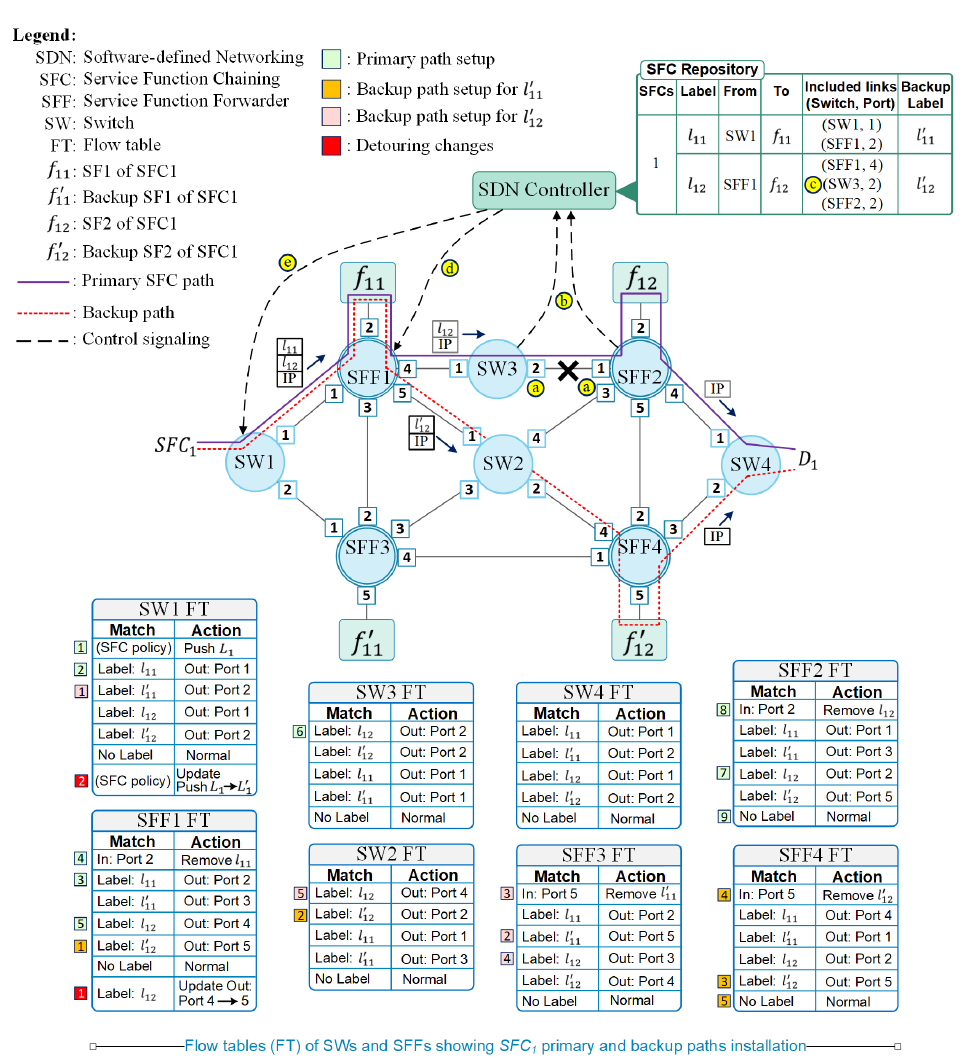
Figure 3. Traffic detouring example for SFC in the proposed hybrid protection mechanism and the flow tables’ configurations for the primary path, backup path, and traffic detouring in the case of